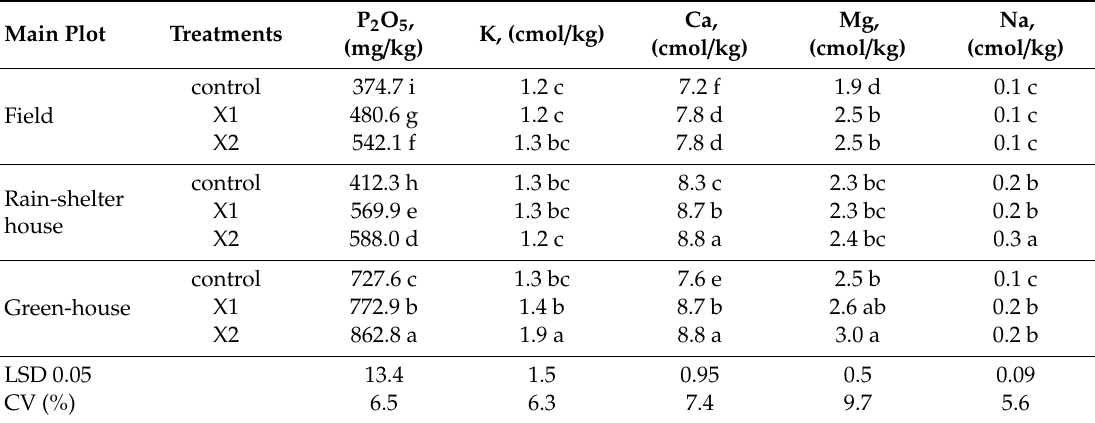
Table 10. E ff ects of di ff erent rates of organic manure application on soil chemical contents at the end of the